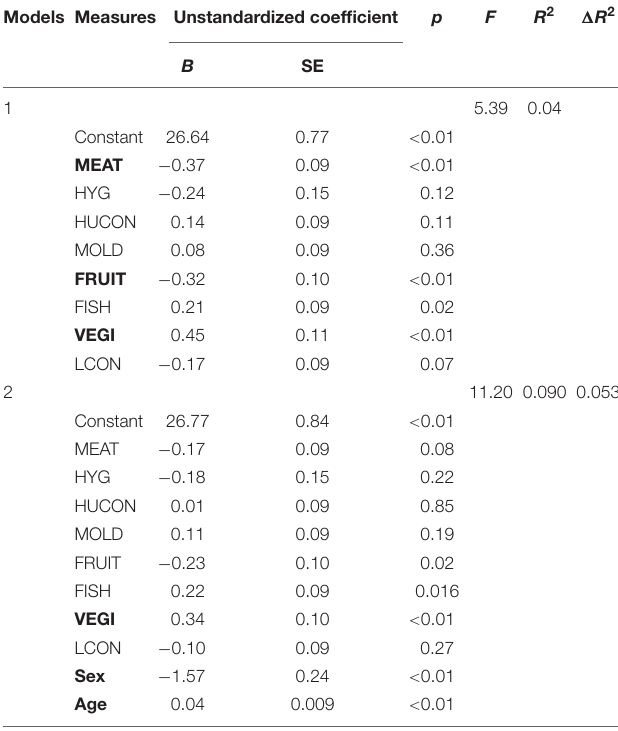
TABLE 3 | Hierarchical linear regression analyses testing effect of FDS-Sp subscales, sex and age on BMI ( n = 1149). Models Measures Unstandardized